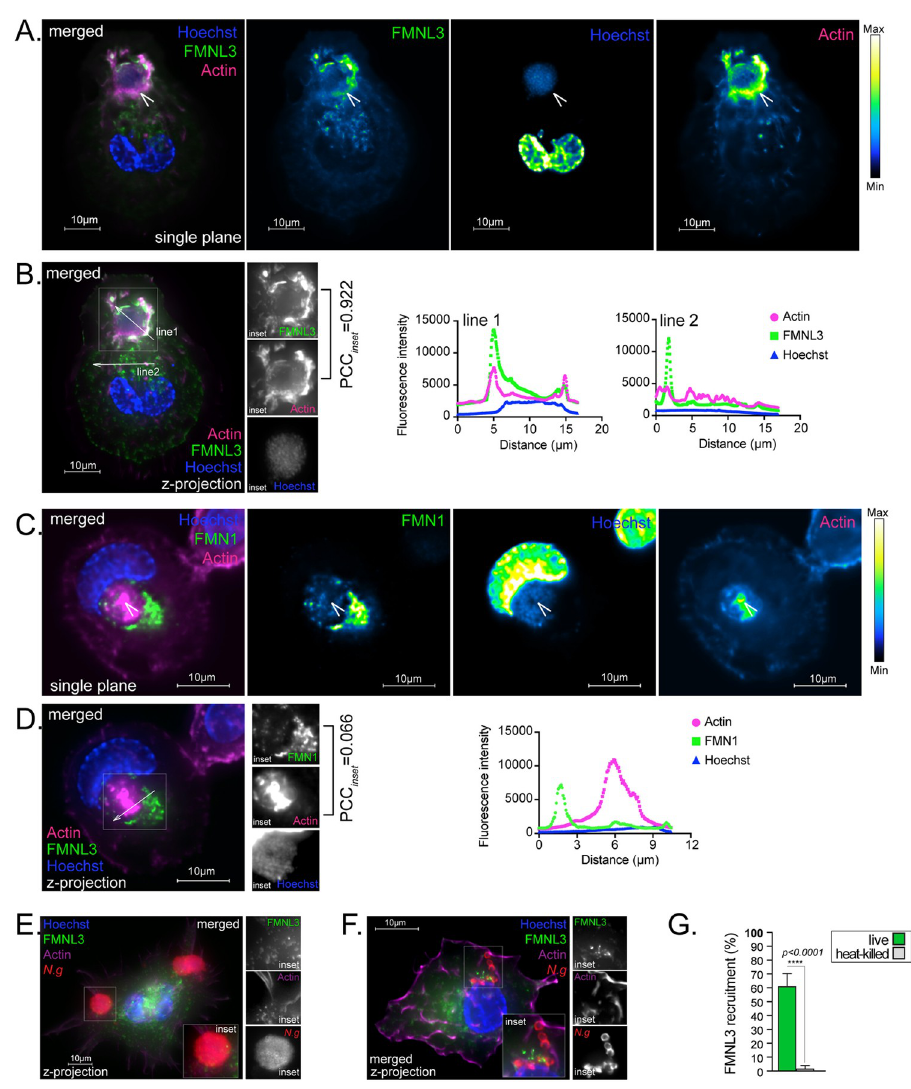
Fig 9. FMNL3 co-localizes with polymerized actin at the sites of N.g colony plasma membrane invasion. Micrographs show U937 MFs expressing FMNL3-V5 (A-B, E-F) or FMN1-V5 (C-D). (A-D) Representative micrographs showing FMNL3-V5 (A-B) but not FMN1-V5 (C-D) localizes at the actin ruffles at the plasma membrane surrounding an invading N . g FA1090 colony. Single plane image is shown in (A and C) from the z-projection image shown in (B and D) . Individual channels of the merged image in (A) are pseudo-colored with the Kindlmann color map for range visualization of the fluorescent signal intensity. Fluorescent signal for actin and FMNL3 colocalize at the site of N . g invasion (PCC = 0.922) (B) , whereas actin and FMN1 do not (PCC = 0.066). Fluorescent signal intensity profiles are shown in (B and D) for line 1 drawn along the invading colony and line 2 drawn across another area of the cell. (E-G) Plasma membrane region proximal to surface-associated gonococcal colonies (E) or aggregates of heat- killed gonococci (F) did not accumulate FMNL3 and actin microfilaments. (G) Quantitative analysis of FMNL3 accumulation at plasma membrane sites in contact with live gonococcal colonies or with aggregates of heat-killed gonococci. Means from two biological replicates ± SD. The statistical significance was calculated using the unpaired T- test. (A-G) Representative experiments from two (F-G) or at least three (A-E) biological replicates are